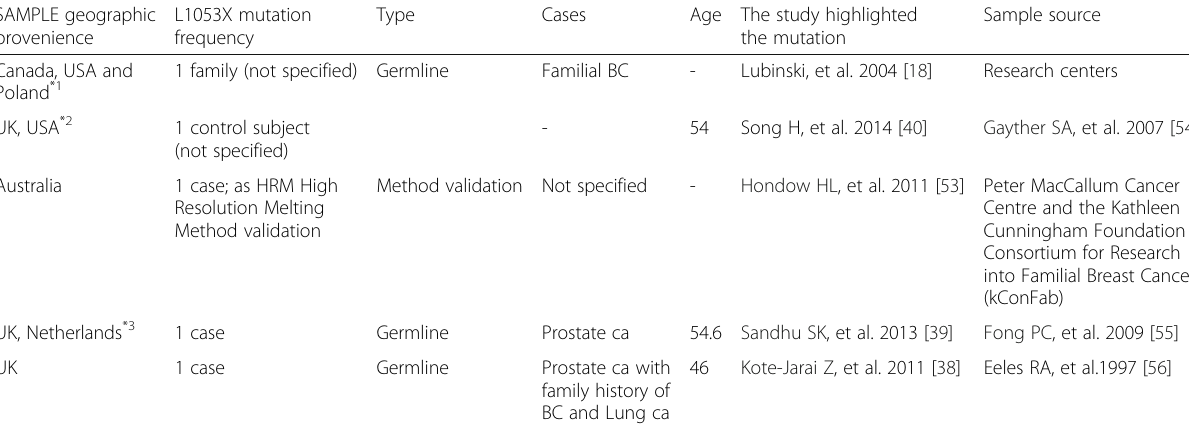
Table 6 The geographic provenience of the samples previously detected with the mutation L1053X SAMPLE geographic